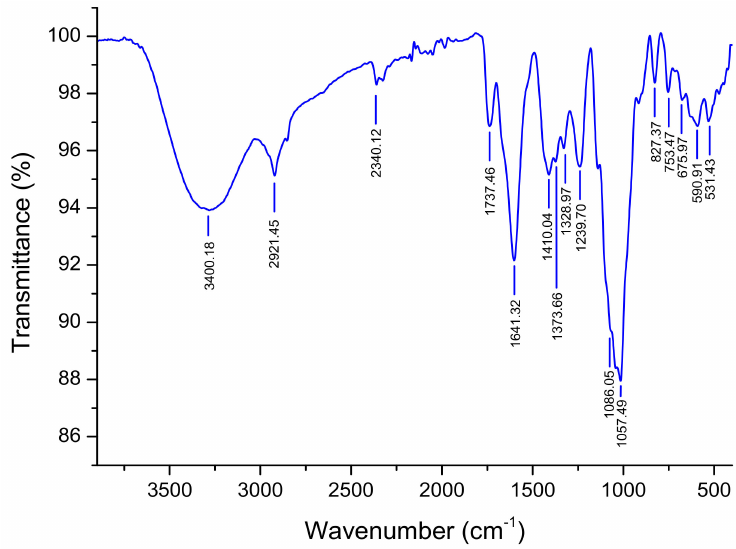
Figure 3. FTIR spectrum of